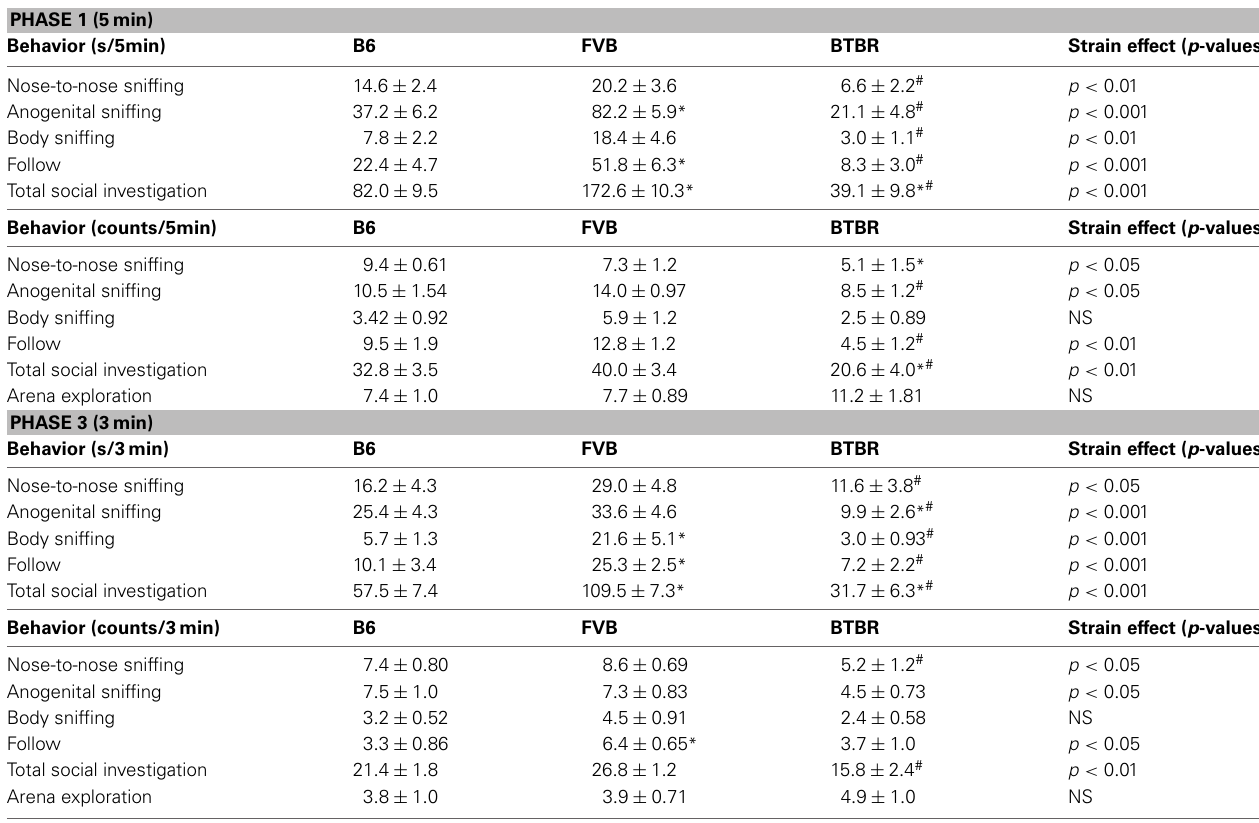
Table 2 | Strain differences in male social behaviors during the first interaction with the female (phase 1) and second interaction with the female (phase